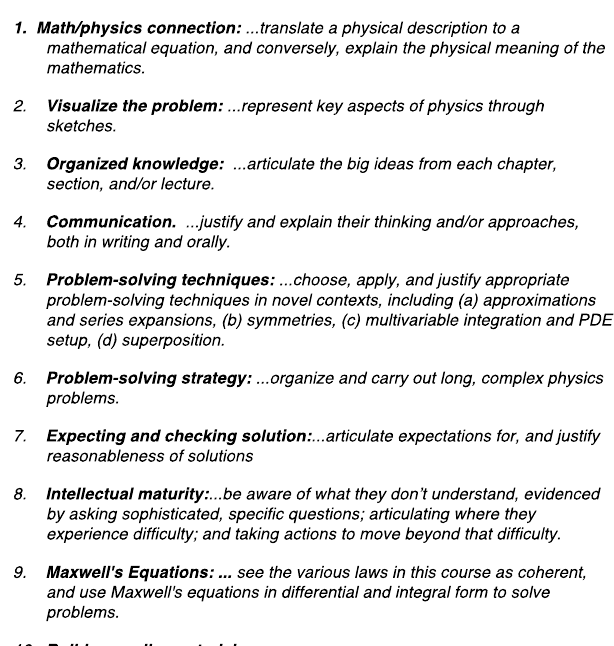
FIG. 1 (color online). Abbreviated course-scale learning goals for PHYS301, developed by the faculty working group. The full set of learning goals is available at